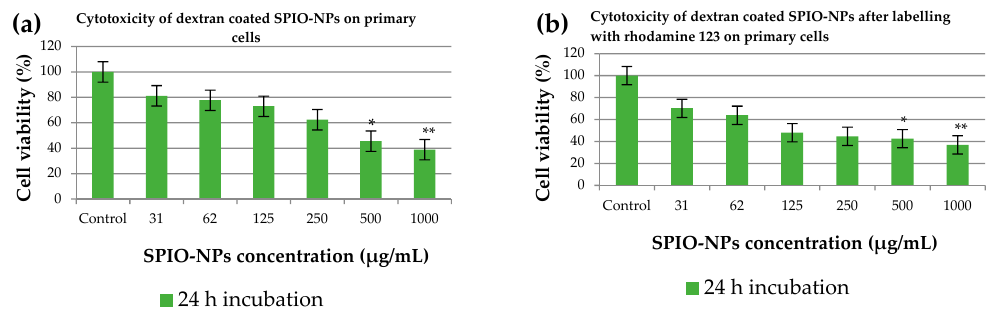
Figure 4. The effects of dextran 70,000-SPIO-NPs ( a ), and dextran 70,000-SPIO-NPs labelled with rhodamine 123 ( b ) on viability of primary cells, determined by MTT assay. Statistical analysis revealed that both SPIO-NPs variants induce significant reduction in viability at 500 and 1000 µ g/mL. For each group, 5 wells per plate were treated identically, and each experiment was performed with 3 plates, * p < 0.05; ** p < 0.01 as compared to